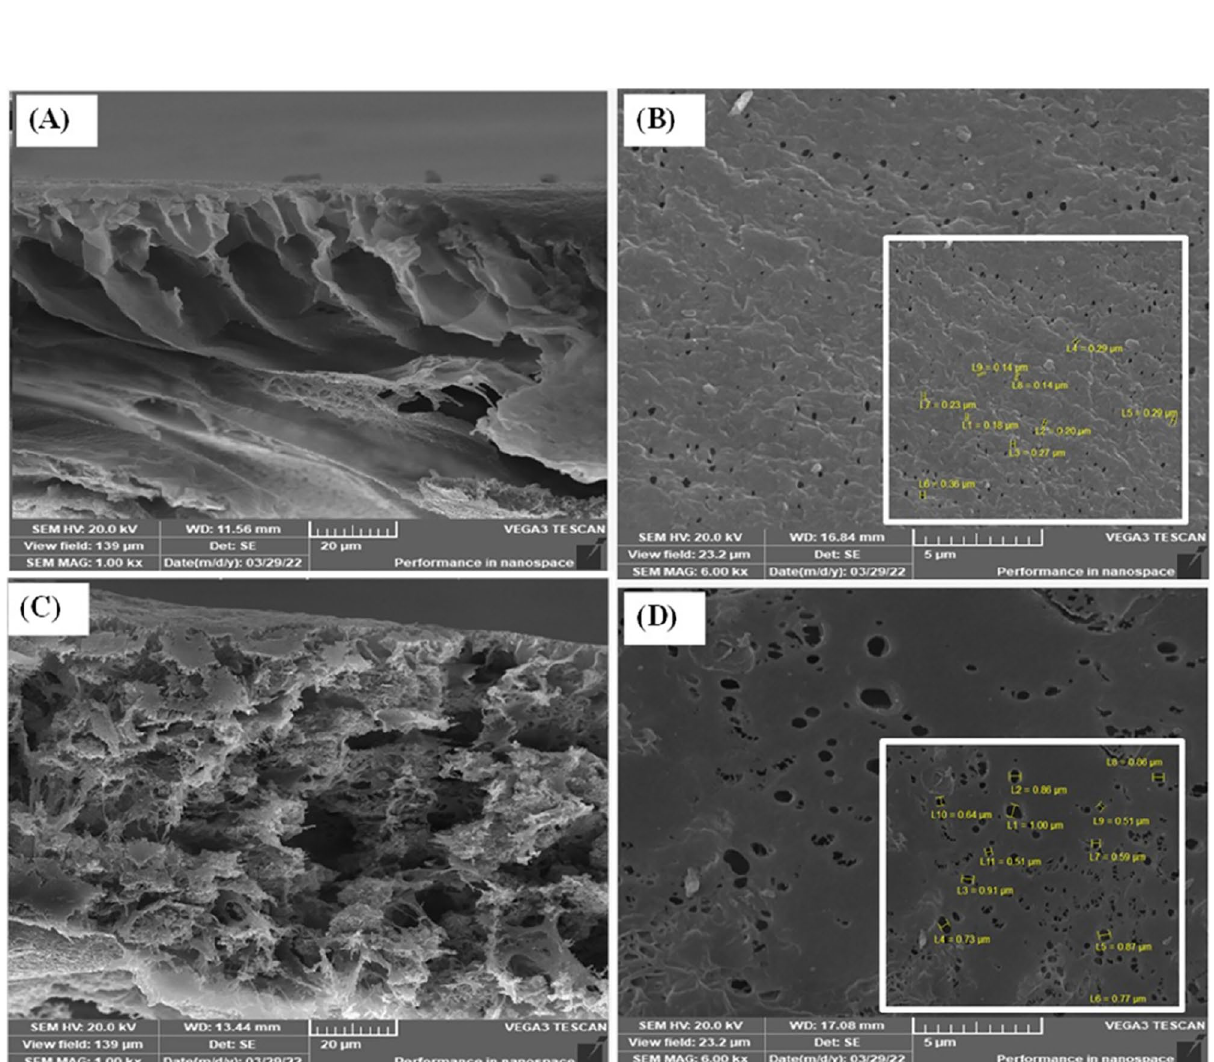
Figure 7. SEM images for the prepared biosorbents, ( A ) The internal structure of the blank PES, ( B ) The surface structure of the PES, ( C ) The internal structure of the immobilized biosorbent, and ( D ) The surface structure of the immobilized